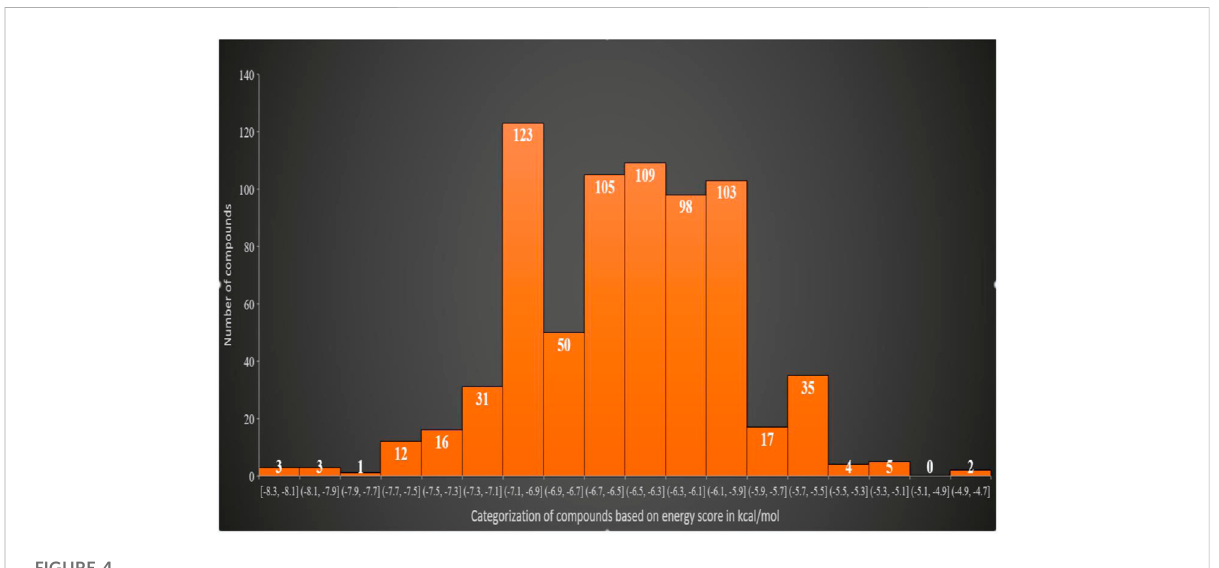
FIGURE 4 Classi fi cation of the best binding drug molecules to an FGF2 receptor based on the binding energy range in kcal/mol. The fi rst three drug molecules are placed in the fi rst place as can be seen in the fi rst